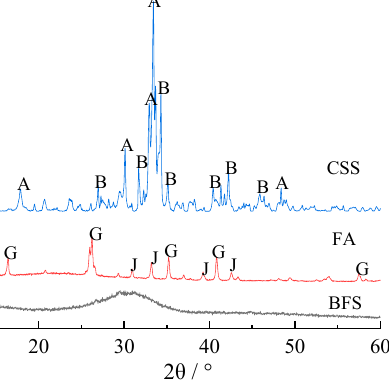
Figure 1. XRD patterns of raw materials. A, β -dicalcium silicate ( β -2CaO · SiO 2 ); B, calcite (CaCO 3 ); G, mullite (3Al 2 O 3 · 2SiO 2 ); J, quartz (SiO 2 ).